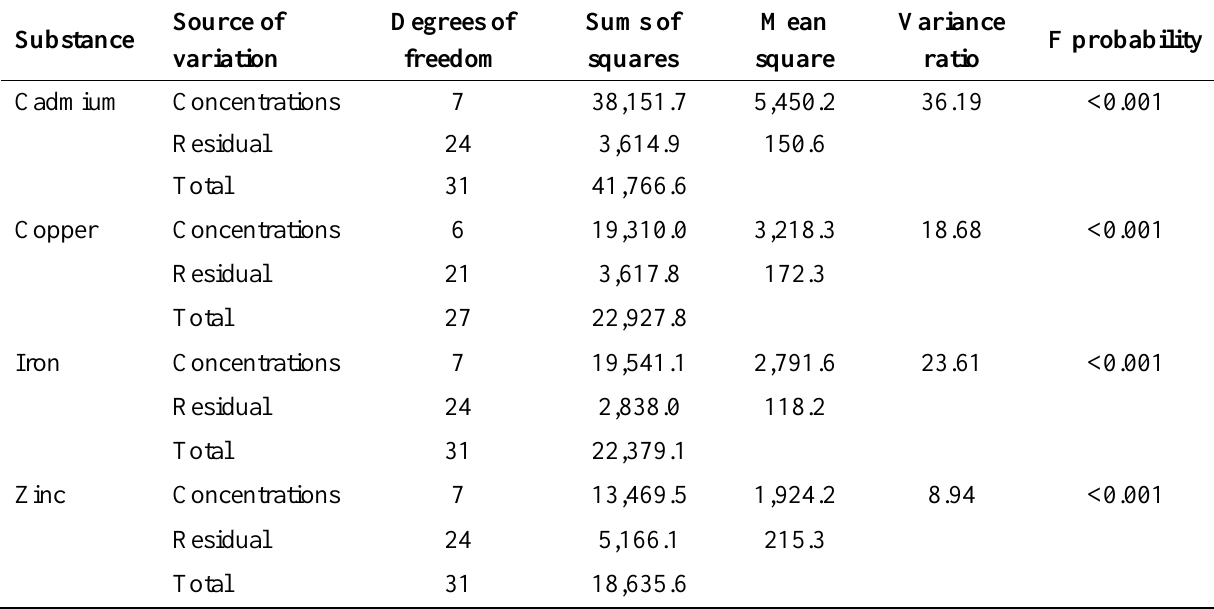
Table 2. One-way ANOVA table of the mobility of the nauplii monitored in Cadmium, Iron, Copper and Zinc